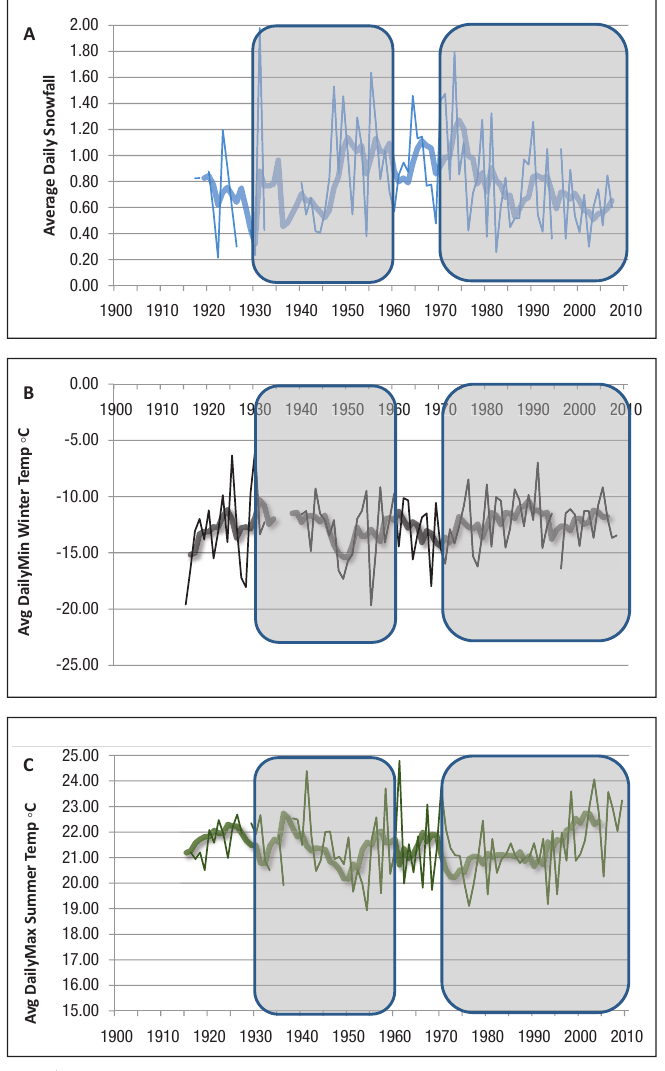
Fig. 4. A) Snowfall, B) average daily minimum winter temperature, and C) average daily maximum summer temperature for Jasper National Park 1900-2009. Grey polygons represent eras within which wildlife abundance trends were consistent. Thick lines depict five year running